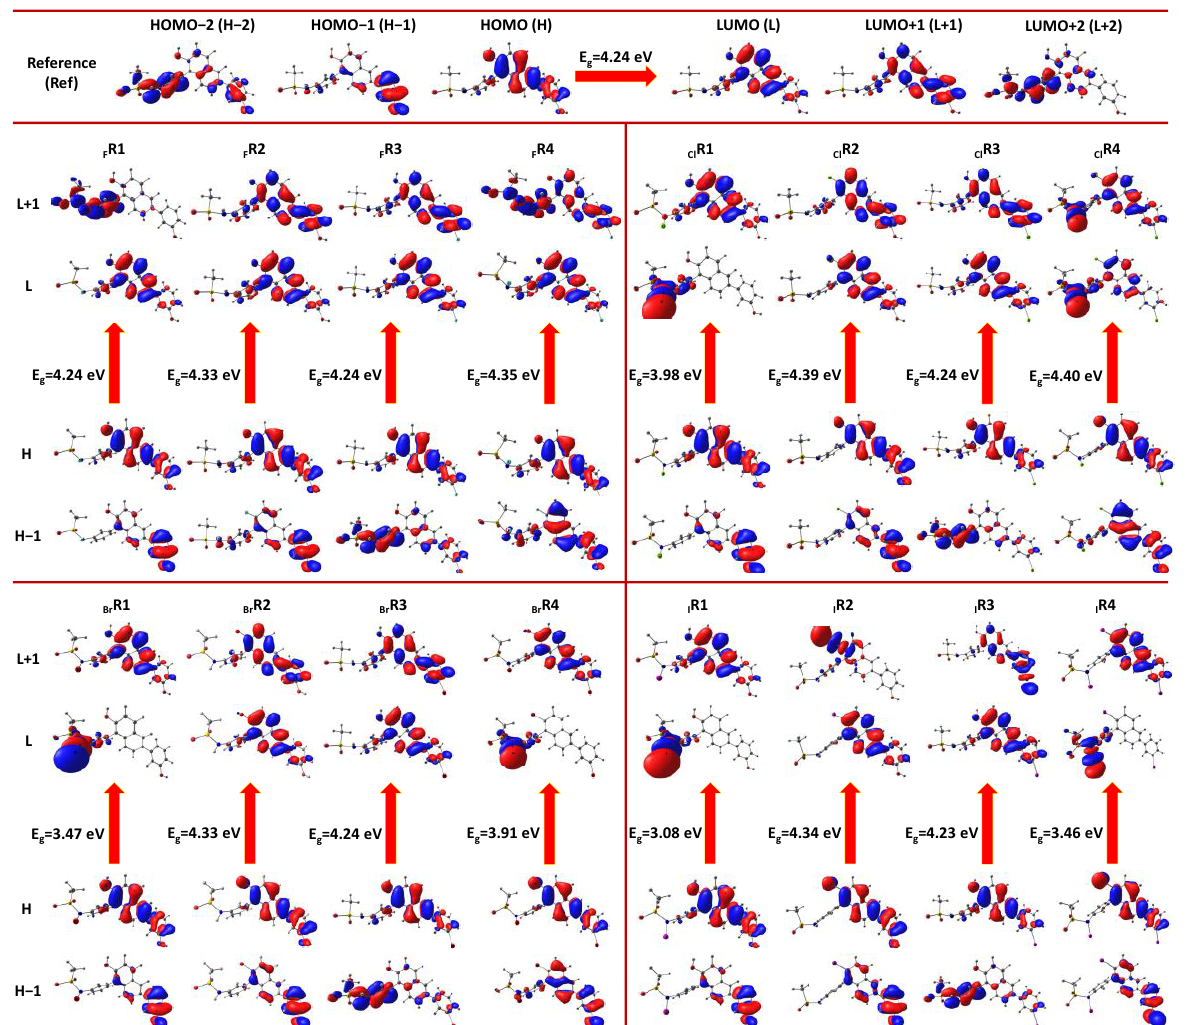
Figure 2. FMO analyses and their HOMO–LUMO gaps (in eV) for all halogen-substituted molecules in comparison to the reference molecule.